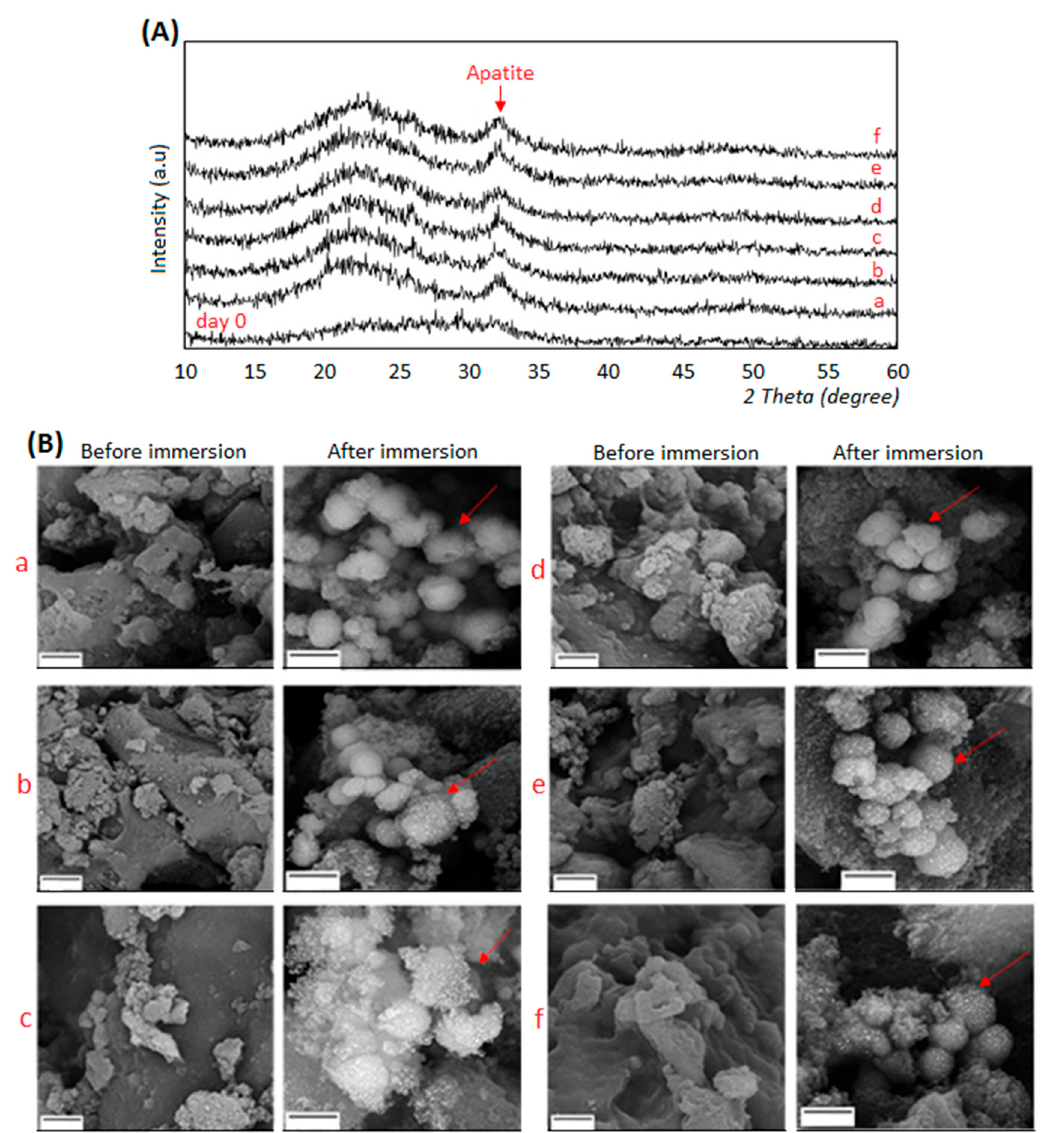
Figure 2. XRD spectra ( A , upper panel) and SEM images ( B , lower panel) of composites before (=day 0) and after immersion in SBF solution for 14 days. Apatite formation was confirmed for all the tested specimens by both XRD that showed typical apatite peaks and SEM whose images demonstrated the presence of crystals aggregates (indicated by the red arrows). SEM magnifications: 15,000× (before immersion) and 20,000× (after immersion), bar scale = 2 μ m. a: BG-Cn-GPTMS10, b: BG-Cn-GPTMS20, c: BG-Gel-GPTMS10, d: BG-Gel-GPTMS20, e: BG-Cn-Gel-GPTMS10, f: BG-Cn-Gel-GPTMS20. BG = Bioactive glass, Cn = chitosan, Gel =